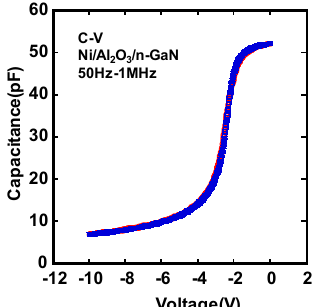
Figure 7. Simulated Mg surface concentration and gate length (L g ) of the GaN DMOSFET fabricated by tilted Mg and Si ion implantation. The lateral expansion of Mg and Si profiles were simulated using the secondary ion mass spectrometry (SIMS) profiles.